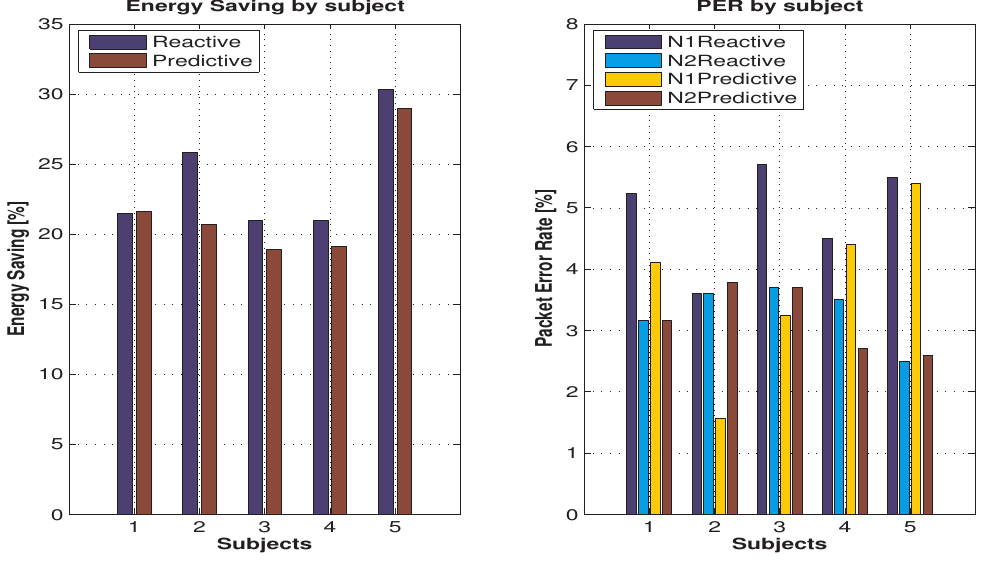
Figure 5. Energy savings and packet error rate for the case study.